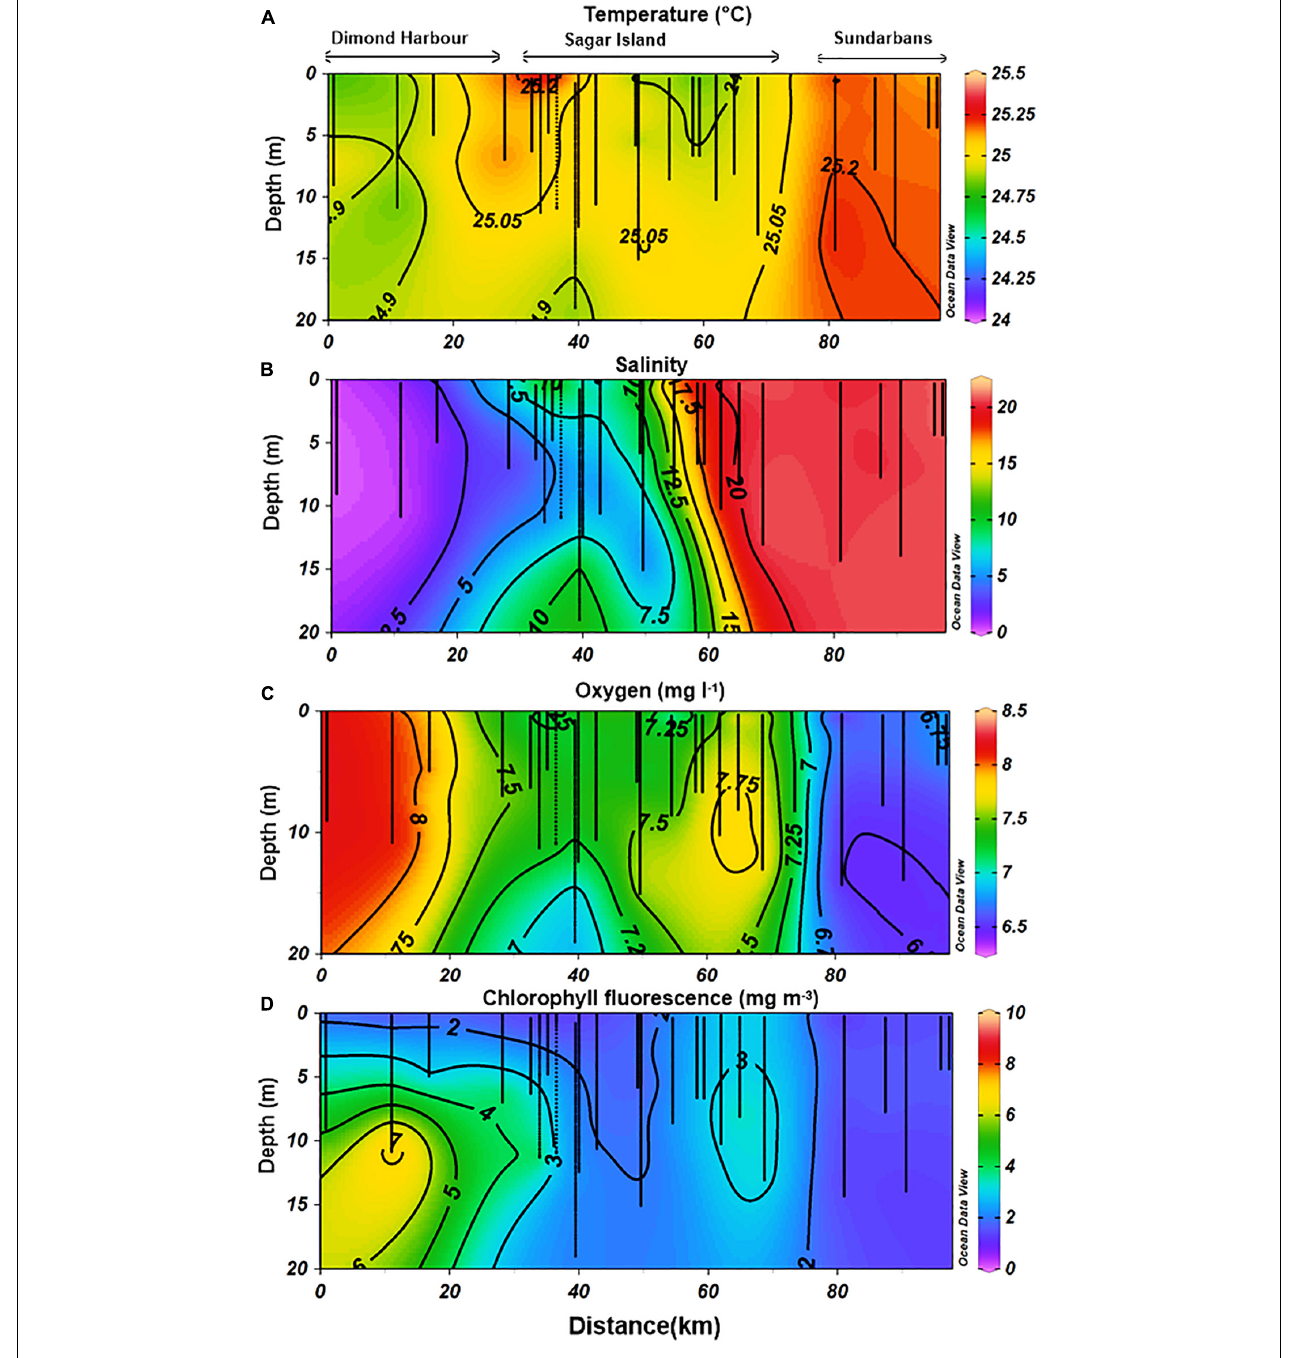
FIGURE 2 | Vertical distribution of (A) temperature ( ◦ C), (B) salinity (psu), (C) oxygen (mg L − 1 ), and (D) chlorophyll fluorescence (mg m − 3 ) in the upper 20 m as observed at 29 stations of the Hooghly estuary (as shown in Figure 1 ). Depths of the conductivity–temperature–depth (CTD) lowered are indicated by the gray lines within the